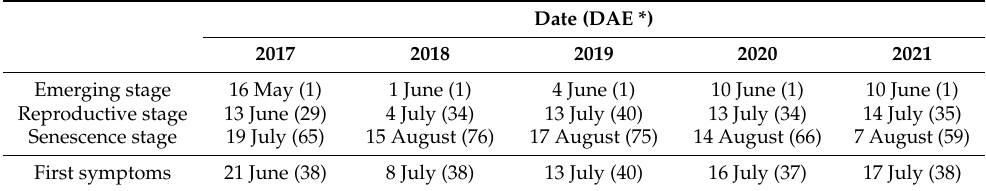
Table 3. Date of phenology stages and first early blight symptoms during the five crop